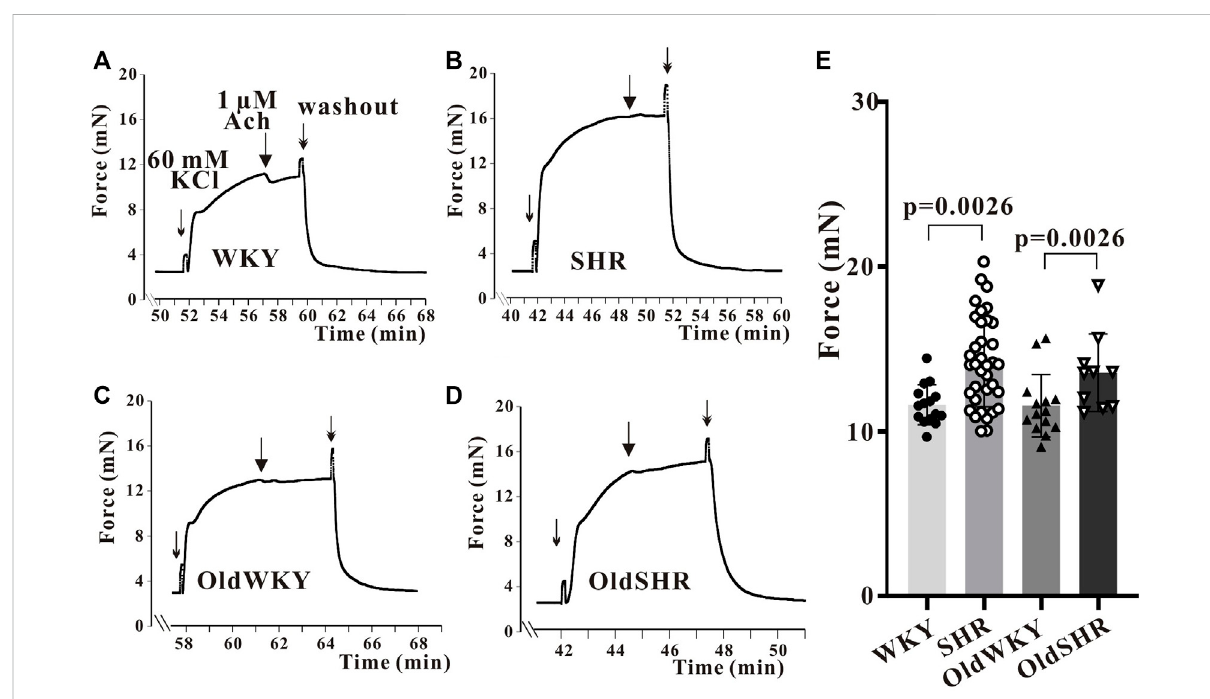
FIGURE 1 HighK + solutioninducedthemaximumcontractionofendothelium-denudedmesentericarteryrings. (A – D) Typicalrecordingsshowingvessel response to60 mM K + solution inthefour groups. TheX-coordinatetimewasrecordedfromthetime whenthevascular ringpassedtheactivitytest and was stabilized for another 30 min. (E) Summary data showed that mesenteric arteries are more sensitive to High K + in hypertension. The mesenteric arteries of rats were obtained from 10 WKY rats, 16 SHR, 8 OldWKY rats, and 5 OldSHR,